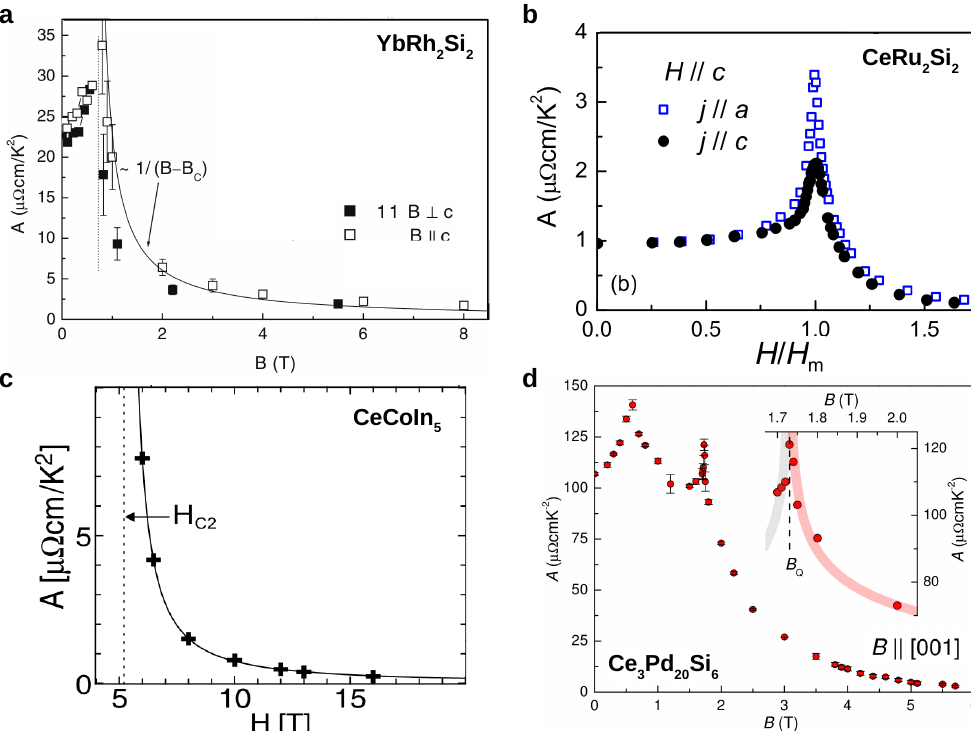
Figure 2. Variation of the A coefficient of the Fermi liquid form of the electrical resistiv- ity, ρ = ρ 0 + AT 2 , across QCPs in various heavy fermion compounds. ( a ) YbRh 2 Si 2 , from [40]. ( b ) CeRu 2 Si 2 , from [56]. ( c ) CeCoIn 5 , from [51]. ( d ) Ce 3 Pd 20 Si 6 , from